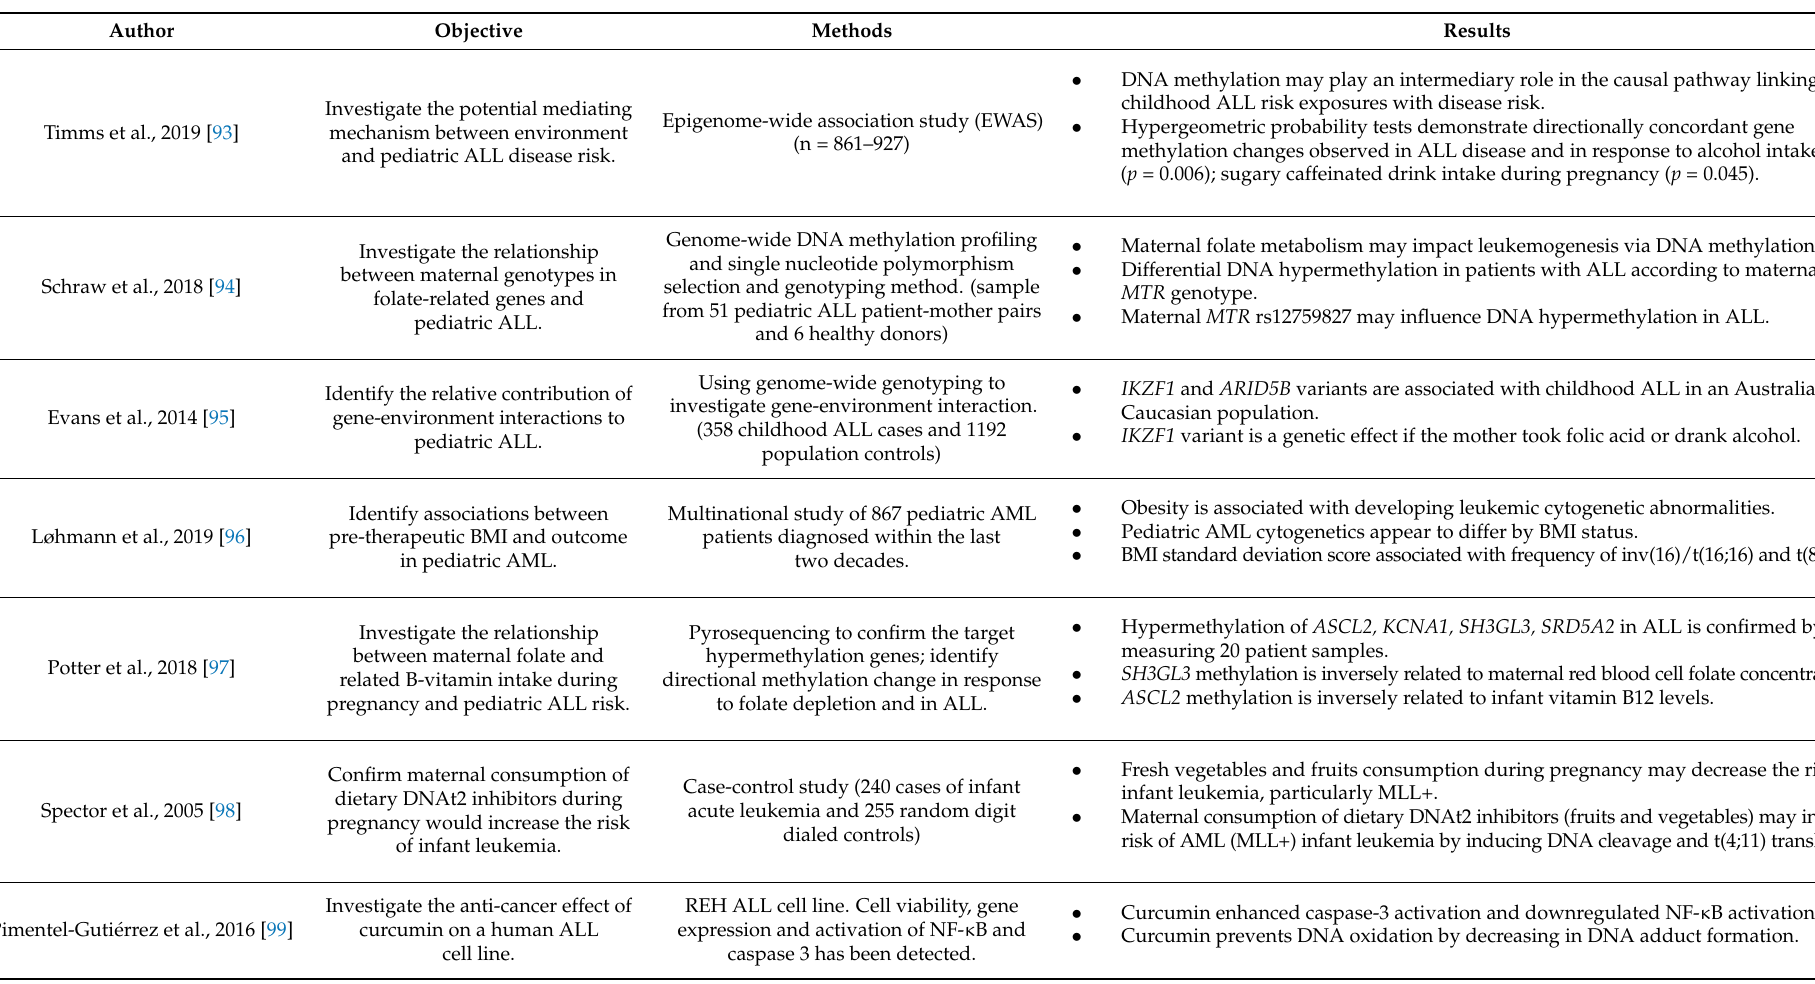
Table 1. Overview of recent nutrigenomic studies in the field of pediatric